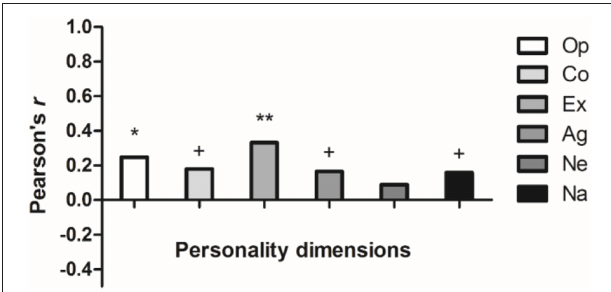
FIGURE 1 | Correlation coefficients between nickname users’ self-reported personality dimensions and participants’ personality judgments based on nicknames. Op, Openness to experience; Co, Conscientiousness; Ex, Extraversion; Ag, Agreeableness; Ne, Neuroticism; Na, Narcissism. + p < 0.10, * p < 0.05, ** p <